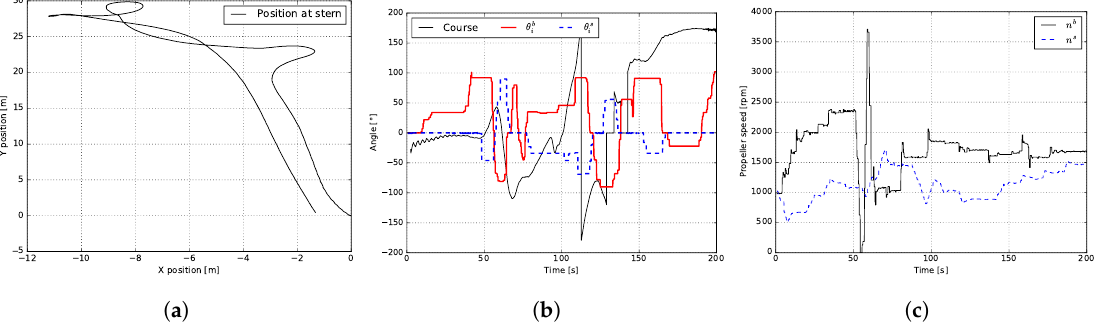
Figure 13. USV under I-SCC motion control in a canal (Leuven): ( a ) sailed trajectory, ( b ) internal actuation angles and USV course, and ( c ) actuation rotational speeds.